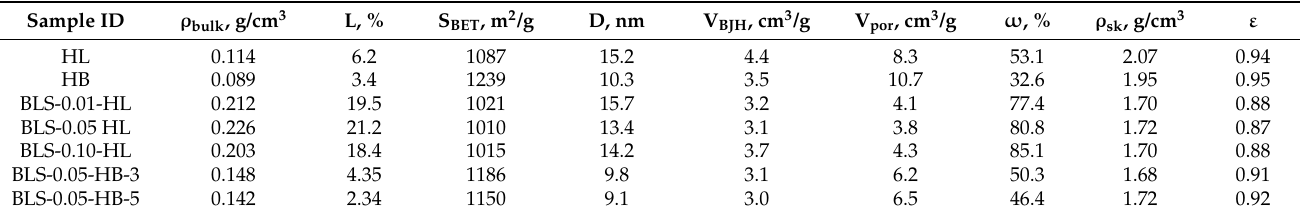
Table 3. Physicochemical properties and structural parameters of silica aerogels and BoronLightSil